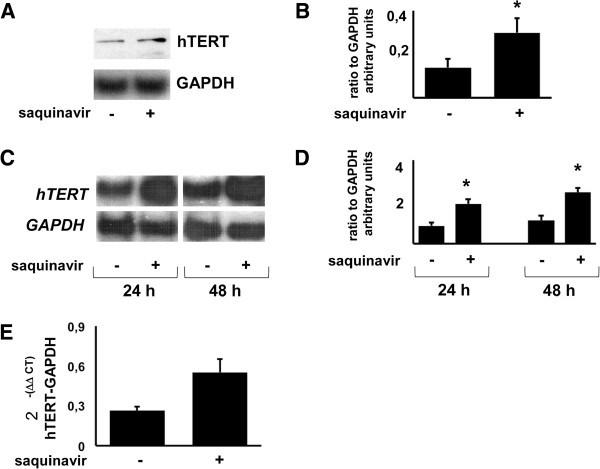
Effect of saquinavir on hTERT expression. A. Representative experiment showing the effect of saquinavir (15 μM) on hTERT expression tested on whole cell extracts from 2×106 viable CD4+ Jurkat cells 48 h following treatment (Western Blot). Gel loading control was based on GAPDH expression. Saquinavir increases hTERT levels in Jurkat cells. B. Graph shows the mean ± SD of the ratio hTERT/GAPDH band intensity obtained by pooling the results from 3 independent experiments. C. Representative gel showing the effect of saquinavir on hTERT mRNA in Jurkat cell line, determined after 24 and 48 h of treatment, using RT-PCR. GAPDH was used as internal control. Saquinavir up-regulates hTERT mRNA transcription. D. Graphs show the mean ± SD of OD for 3 independent RT-PCR experiments. E. Effect of saquinavir on hTERT mRNA expression of Jurkat cells 24 hours following treatment analysed by quantitative real-time RT-PCR. Levels of hTERT are normalized against GAPDH housekeeping expression. The graph shows the difference in terms of gene expression working out the Delta Delta CT algorithm between TERT and the housekeeping GAPDH. Data shown are representative of 2 independent experiments. All p values were calculated using one-way paired Student’s t-test. Asterisk indicates p < 0.05.